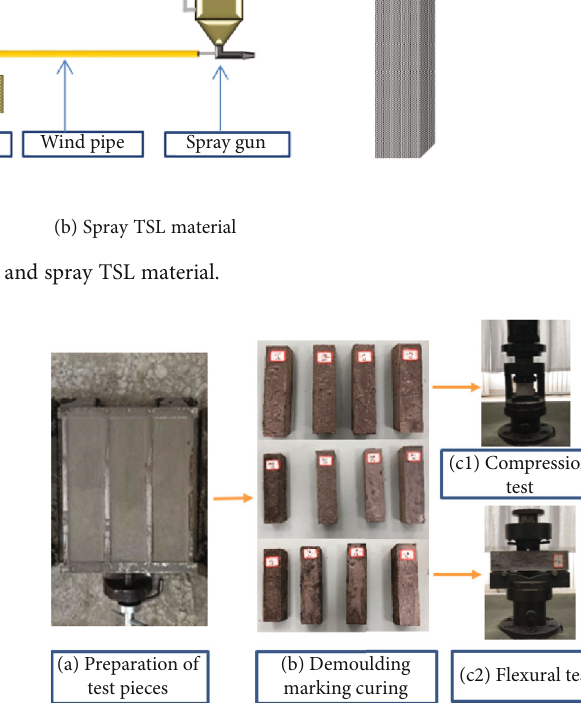
Figure 4: Compression and fl exural test